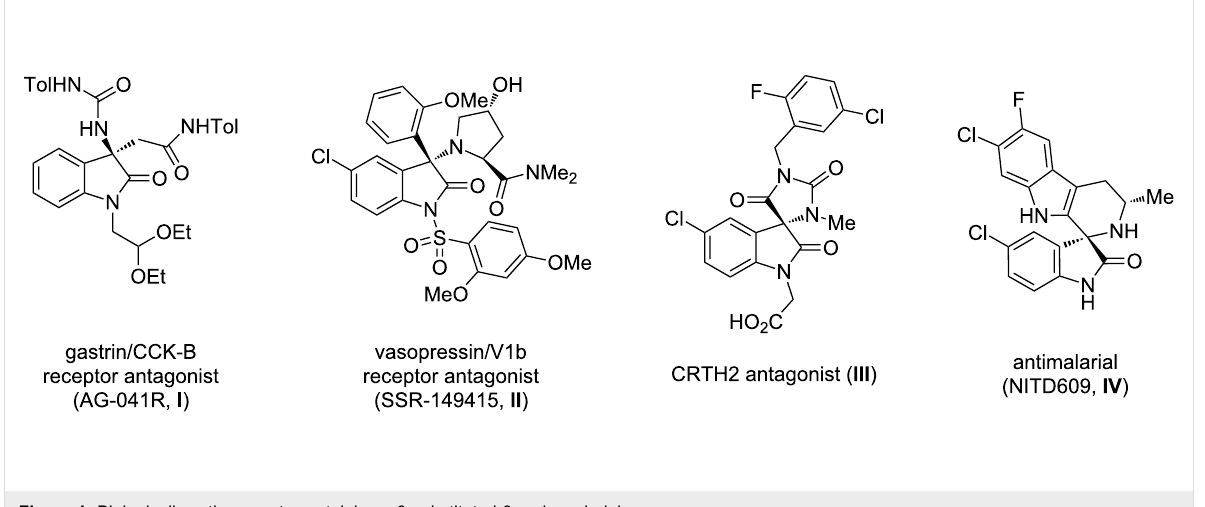
Figure 1: Biologically active agents containing a 3-substituted-3-aminooxindole